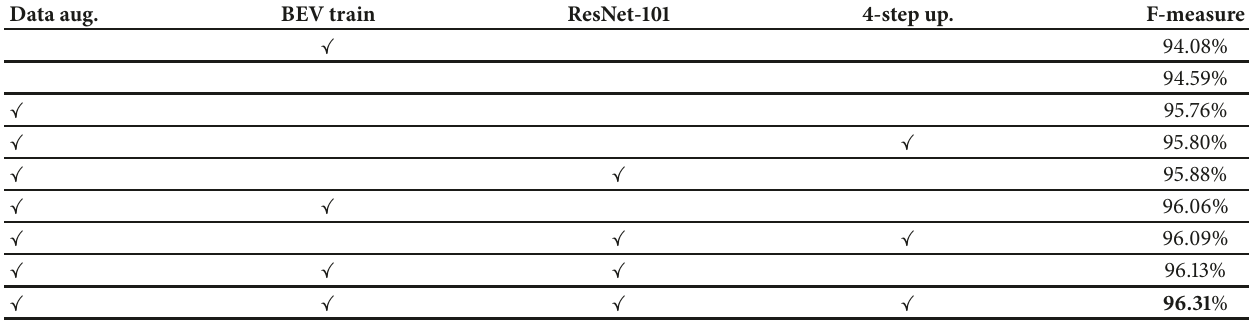
Table 3: Quantitative results in F-measure on KITTI dataset for the main network variants evaluated. Data aug.